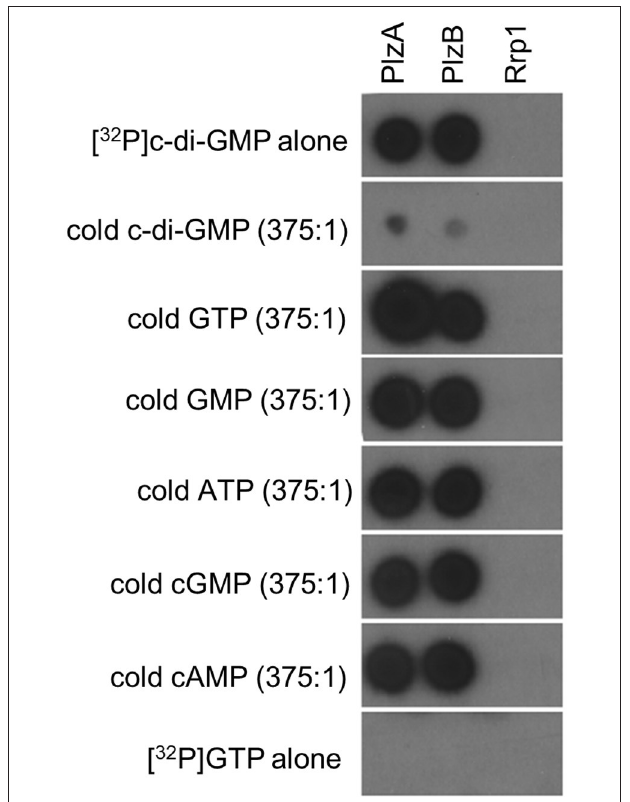
FIGURE 1 | Borrelia burgdorferi PlzB binds to c-di-GMP with high specificity. Equal amounts (0.25 µ g) of recombinant PlzB, PlzA (positive control), and Rrp1(negative control) were spotted onto a series of nitrocellulose membrane strips and incubated with [ 32 P]c-di-GMP alone (top; 2nM) or [ 32 P]c-di-GMP plus a potential competing unlabeled nucleotide (750nM; 375:1 competitor to [ 32 P]c-di-GMP molar ratio). In the bottom, labeled [ 32 P] GTP alone was incubated with the membrane as a control for possible non-specific radiographic signal. After incubation, all membranes were washed identically and exposed to film. All methods are as detailed in the